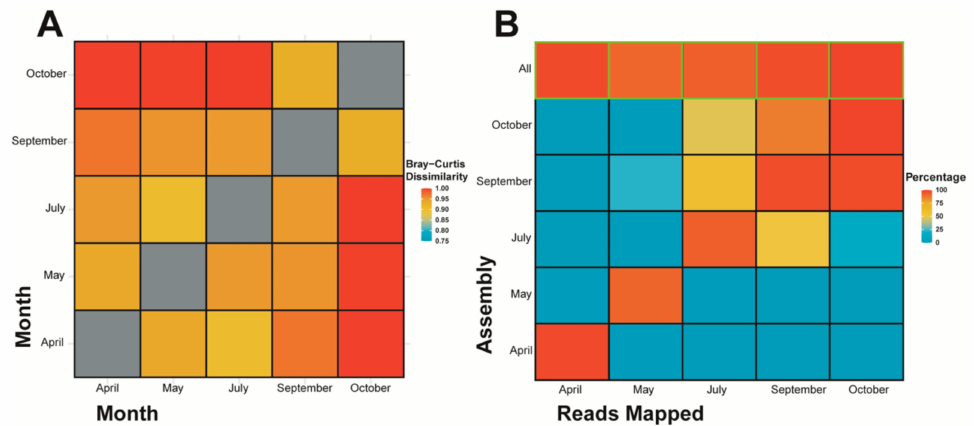
Figure 4. A comparison between samples done using ( A ) Bray-Curtis dissimilarity beta diversity of Illumina Miseq metagenomic assemblies (contigs) as calculated by Simka on k-mers of 21 bp, and the ( B ) percentage of reads mapped from each metagenomic sample (indicated by month of sampling) to assemblies (i.e., contigs) made from their corresponding sample month. Additionally, an assembly from all reads combined (i.e., all metagenomic samples) was produced and reads from each individual month were mapped back to the said assembled contigs (denoted by “All” and highlighted in green).